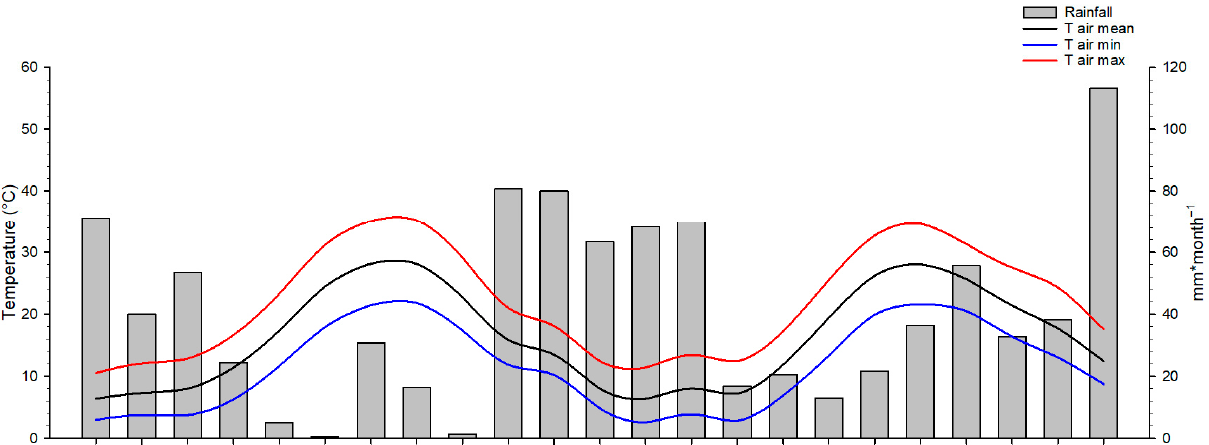
Figure 1. Monthly rainfall and average (T air mean), minimum (T air min) and maximum (T air max) air temperatures in the almond orchard during 2021 and 2022 (Andria, Southern